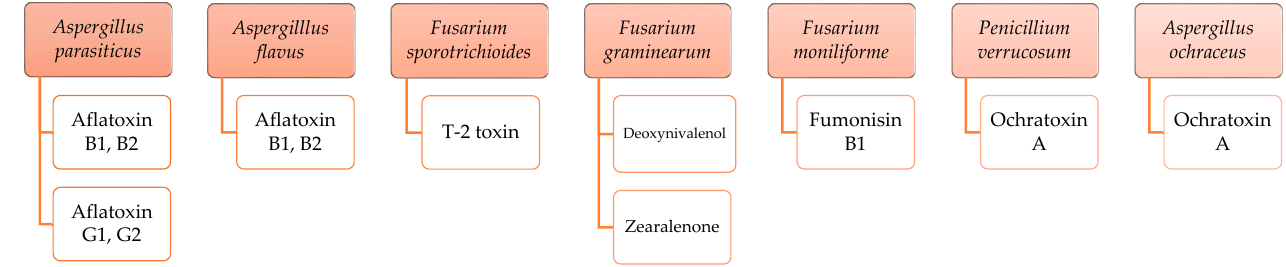
Figure 1. Fungi species and mycotoxins produced of world-wide importance. Adapted from [12,13].